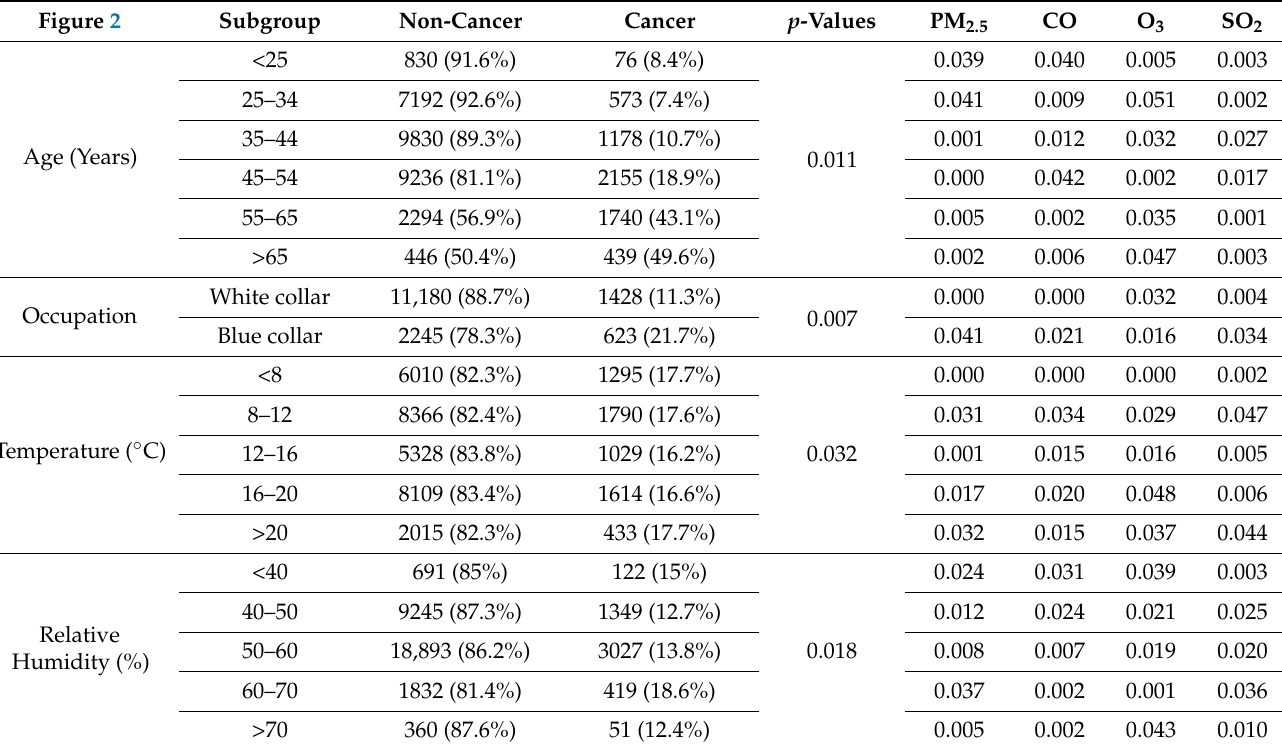
Table 1. Results of Wilcoxon signed-rank tests in different characteristics and environmental factors. Figure